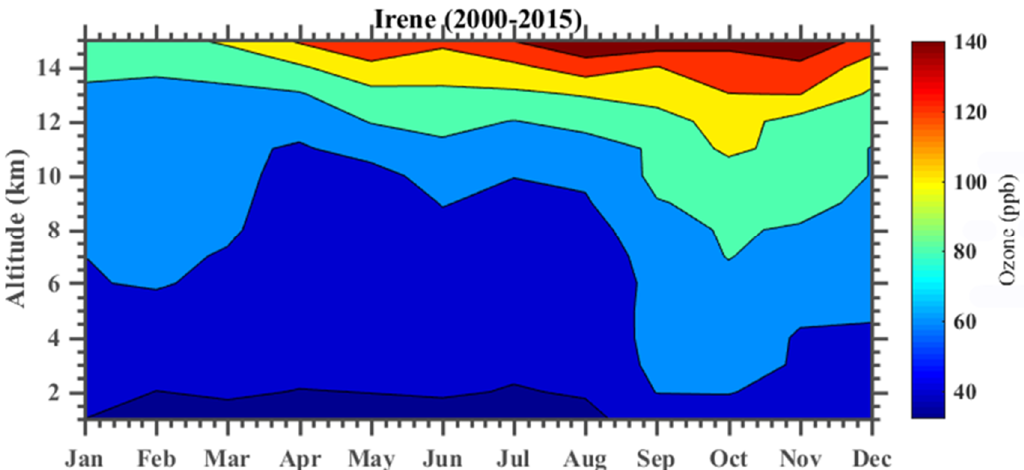
Figure 12. Contour plot of Irene O 3 mole fraction (in ppb) for the period, 2000 to 2015.